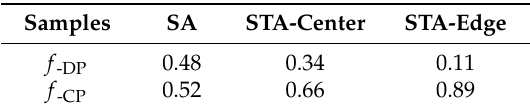
Figure 6. SEM images of ( a ) SA; ( b ) center position of STA and ( c ) edge position of STA. Green dotted lines and red dotted lines outline the grain boundaries and twin boundaries, respectively. The images at the middle are taken at higher magnification from the corresponding marked areas, and those at the right side show the detail observation of two types of precipitates, i.e., CP and DP, at high magnification. Table 2. Average area fractions of CP and DP in various samples.